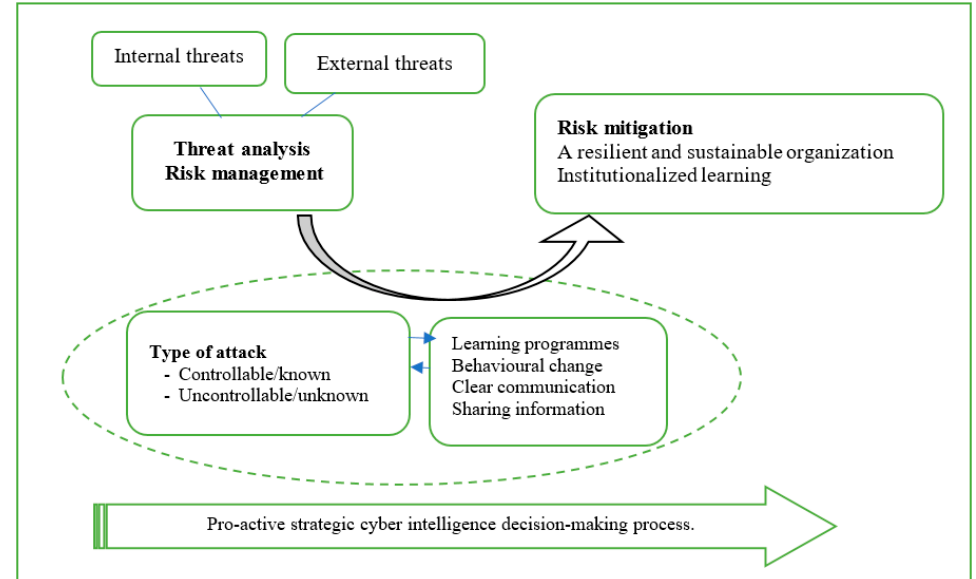
Figure 1. The interactive behavioural cyber security awareness process.